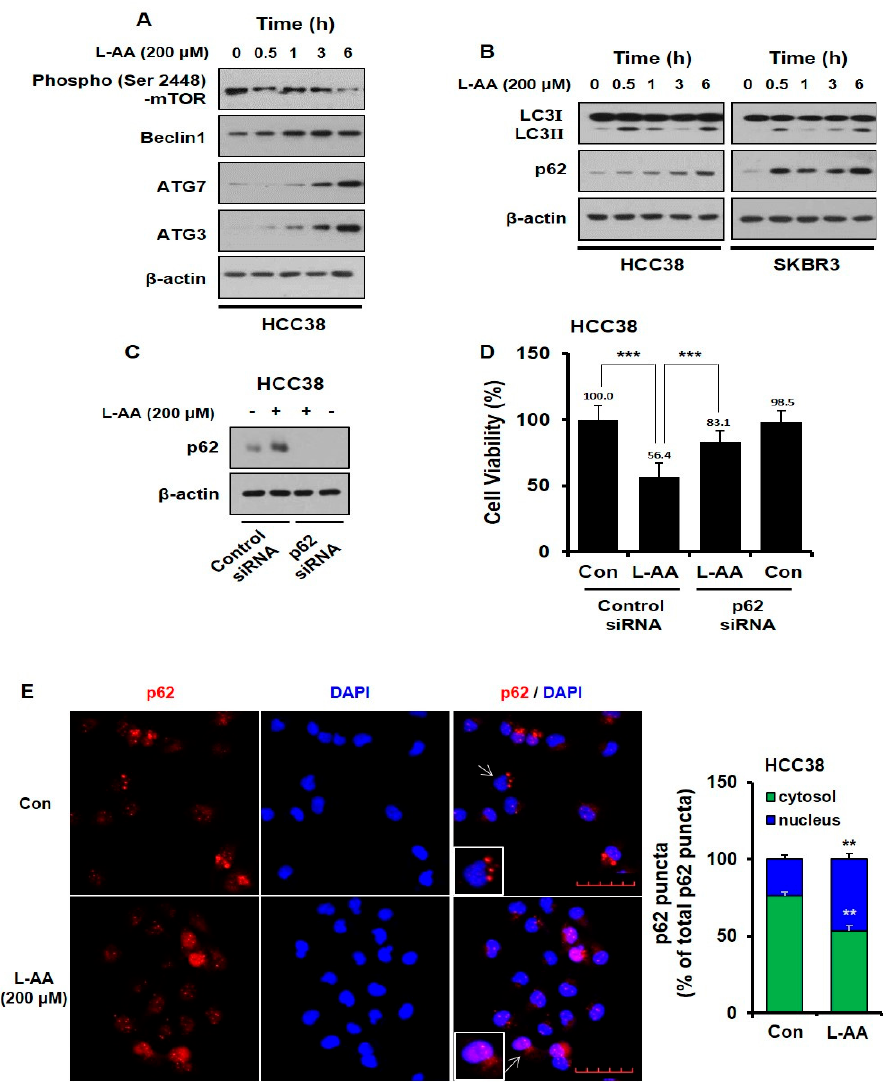
Figure 3. L-AA induces autophagosome formation, while L-AA increases p62 accumulation in the nucleus. ( A,B ) Breast cancer cells were treated with L-AA (200 μ M) for indicated hours (0–6 h) and then western blotting was performed with anti-p- mTOR , -Beclin1, - ATG 7, - ATG 3, - LC3 Ⅰ / Ⅱ , and - p62. β -actin was used as the loading control. ( C,D ) HCC-38 cells were transfected with p62 siRNA and treated with 200 μ M of L-AA. ( C ) Western blotting was performed with anti-p62 and β -actin was used as the internal control. ( D ) Trypan blue assay was performed. ( E ) HCC-38 cells were treated with 200 μ M of L-AA for 6 h. Cells were stained with anti-p62 (1 μ g/mL) and –AlexaFluor-594 secondary antibody (1:200). Images were obtained using the FV10i confocal microscope, using the 40× objective; the scale bar indicates 50 μ m. When the experiment was performed, three or more fields were obtained for each group, and p62 puncta were counted and averaged. This process was repeated three times, and the mean value of three experiments was statistically processed. Data are shown as the mean of three independent experiments, and the error bars represent standard deviation (SD). ** p < 0.01 and *** p < 0.001 were considered statistically significant.